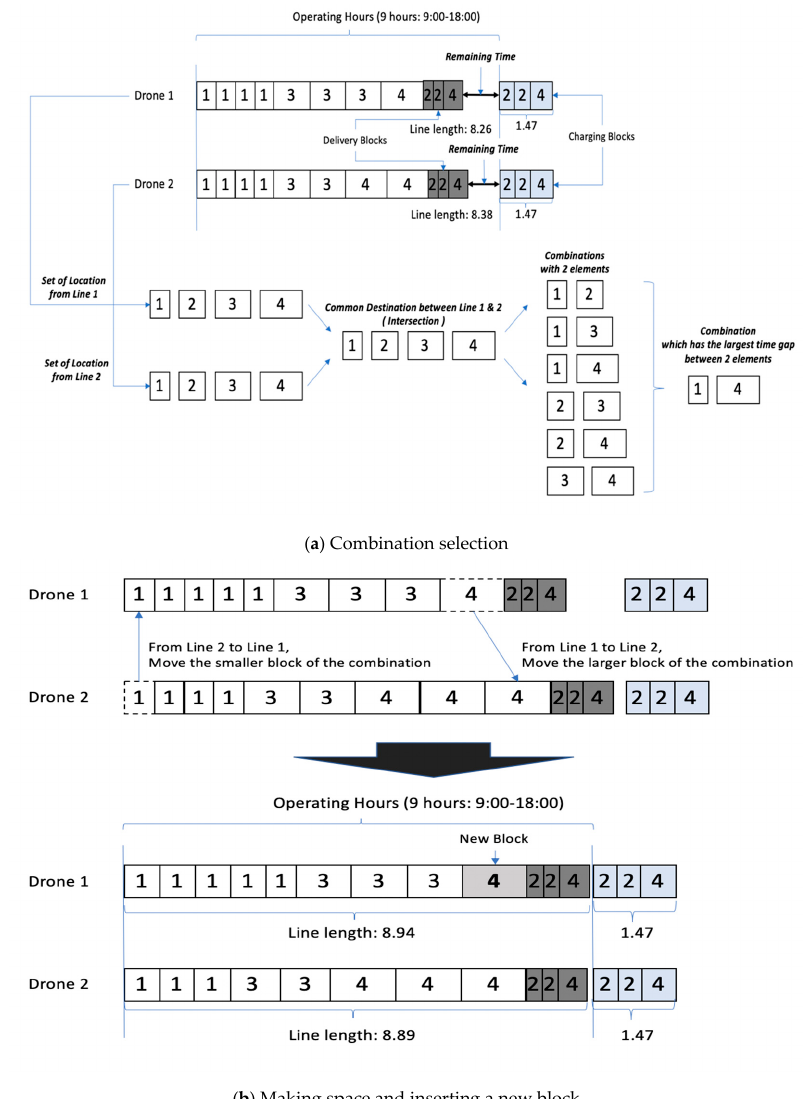
Figure 3. Improving the solution by making space and inserting blocks. Appl. Sci. 2020 , 10 , x FOR PEER REVIEW